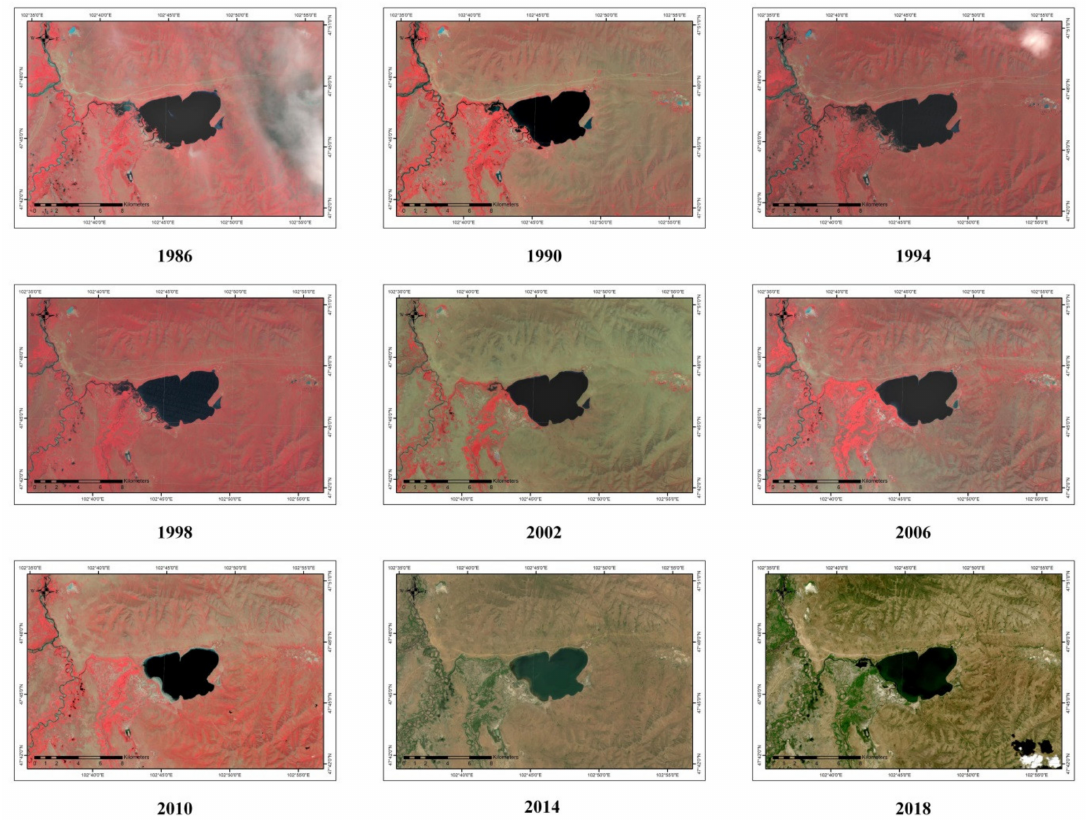
Figure 5. The Ugii Nuur Lake in di ff erent selected years.